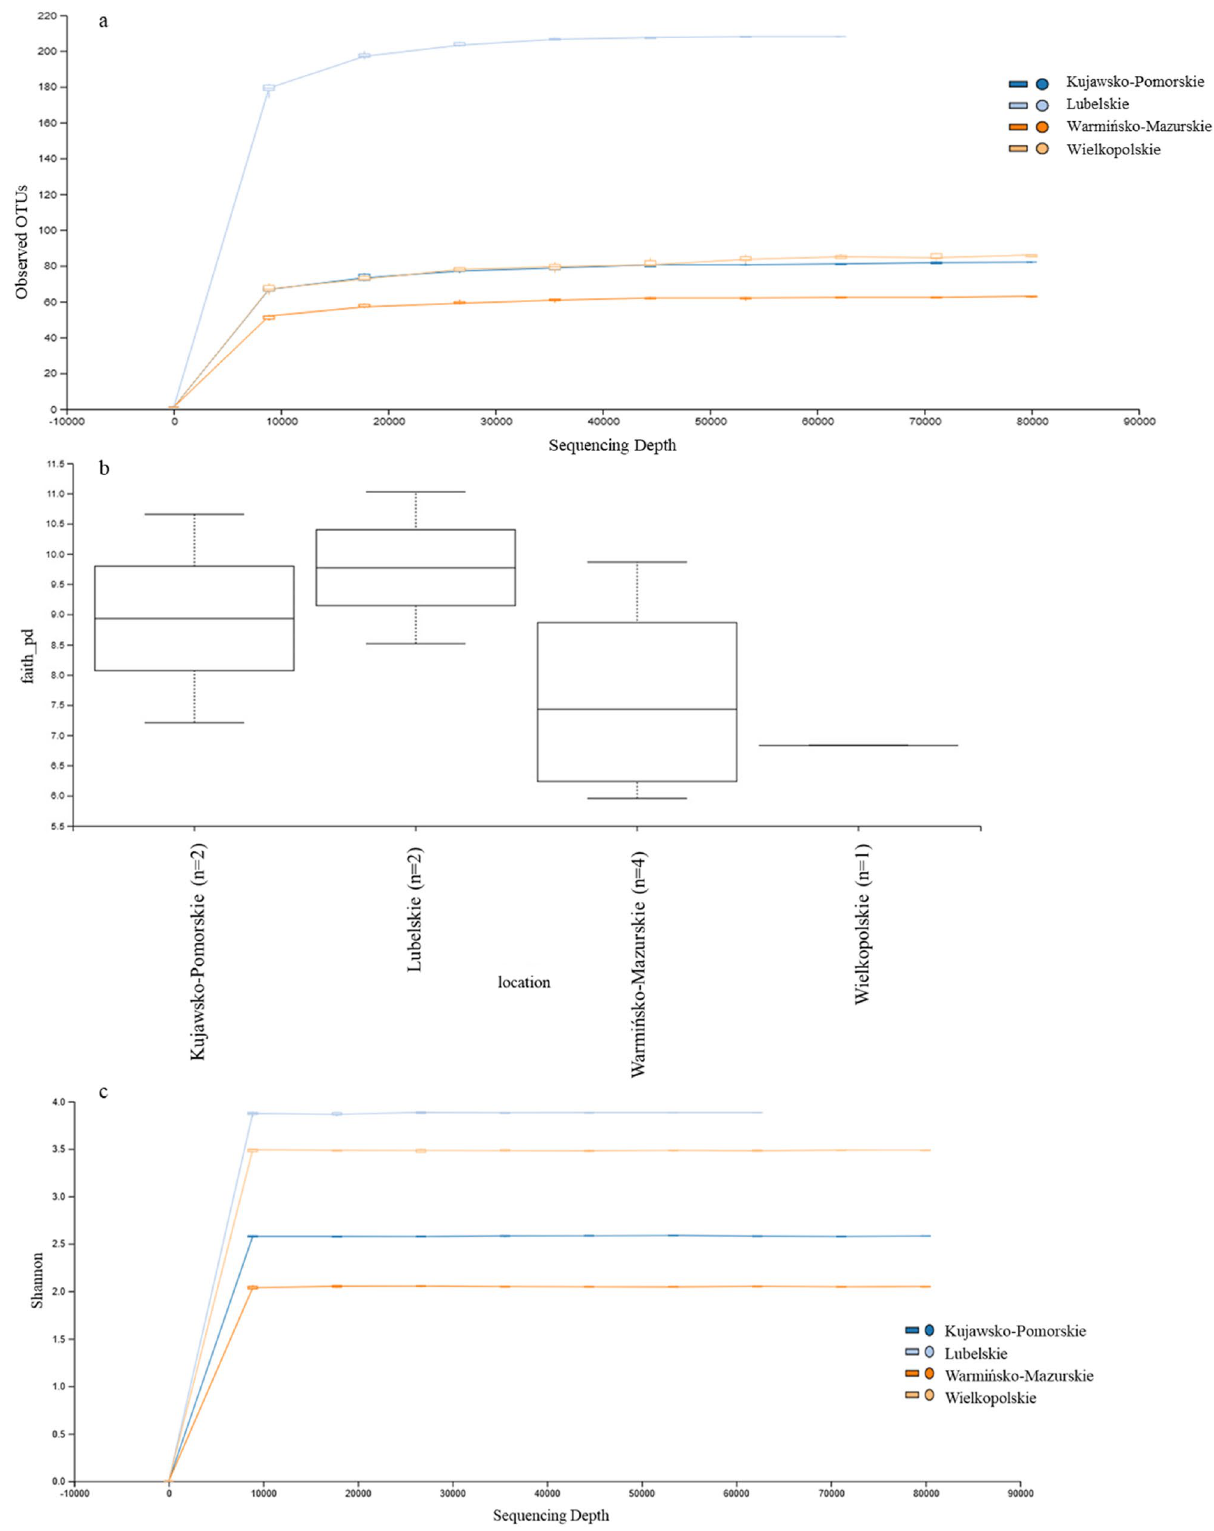
Figure 5. Comparison of URT microbiome of turkeys. ( a ) Observed OTUs comparing geographical location. ( b ) The Faith PD boxplots. ( c ) Shannon diversity index comparing samples from different geographical